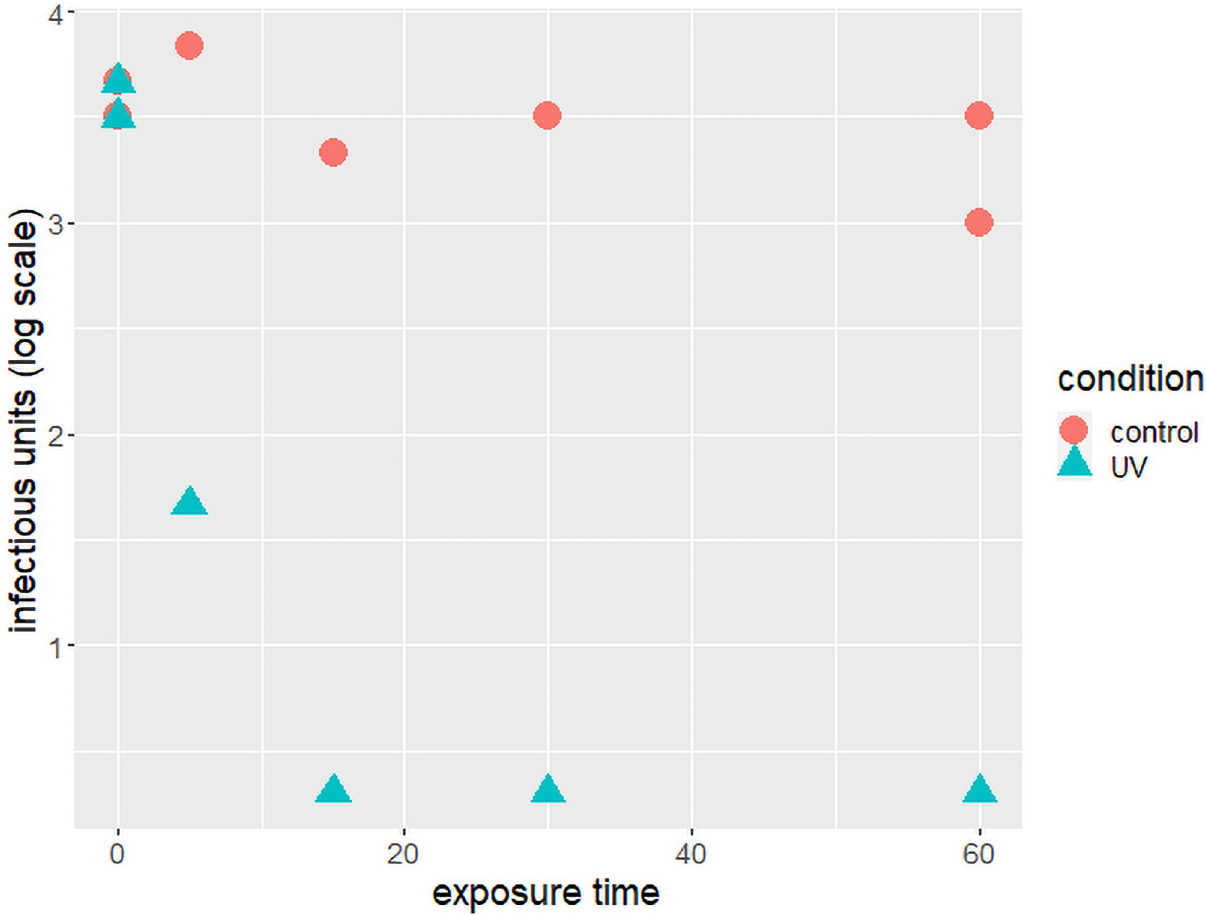
Fig 4. Infectious units recovered in UV exposed versus control masks strips. 20 minutes of UV-C radiation in a BSC was sufficient to achieve more than a 3 log reduction in viral recovery of the NL63 coronavirus.